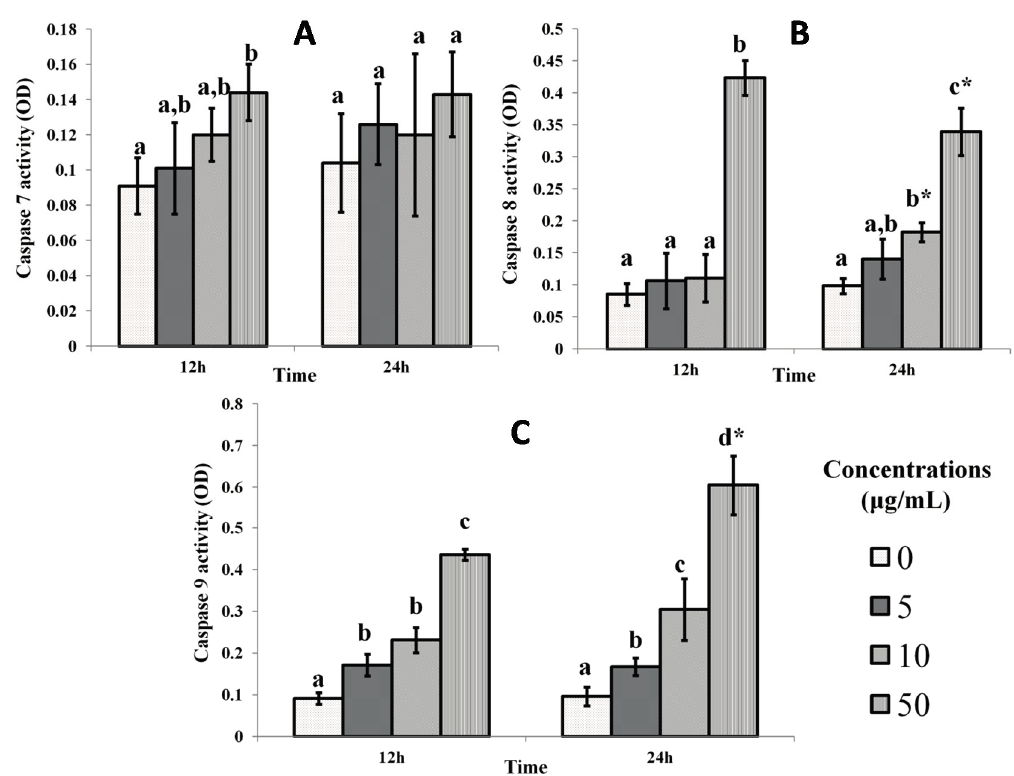
Figure 3. Effect of mango kernel extract on ( A ) caspases-3, ( B ) -8 and ( C ) -9 activities in MCF-7 cells. Treatment with 5, 10 and 50 μ g/mL of extract over 12 and 24 h increased the levels of all caspases by 24 h, especially with the highest dose. Bars with different letters for any time period of an assay indicate a significant difference ( p < 0.05). * Significant difference between 12 and 24 h treatments with the same concentrations of